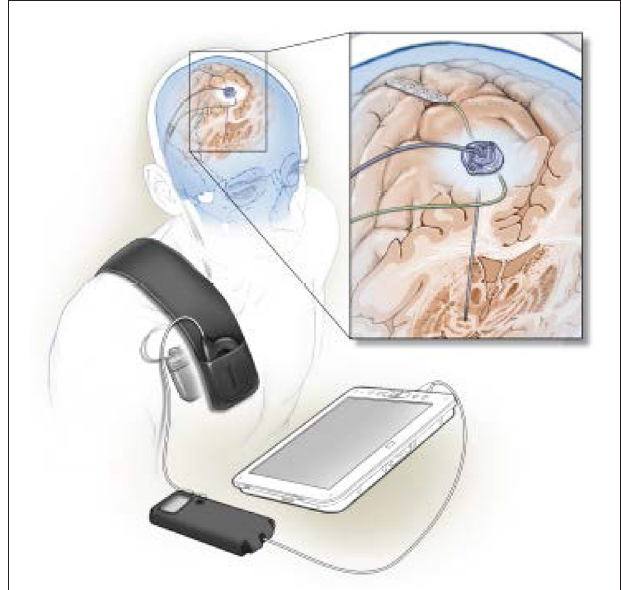
FIGURE 1 | Illustration of a totally implanted bidirectional neural interface designed for chronic multisite recording in humans, as well as therapeutic neurostimulation. Quadripolar electrode arrays are implanted in the subthalamic nucleus and over motor cortex (enlarged view in inset), and attached to Activa PC + S (Medtronic Inc.) implanted over the pectoralis muscle. Data are non-invasively downloaded to an external tablet computer by radiotelemetry. The device is used to characterize networks related to abnormal movement in Parkinson’s disease ( Swann et al., 2016) and to prototype control algorithms for closed loop stimulation (Swann et al., 2018). This art, by UCSF medical illustrator Ken Probst, is also published in Swann et al. ( Swann et al., 2017), with